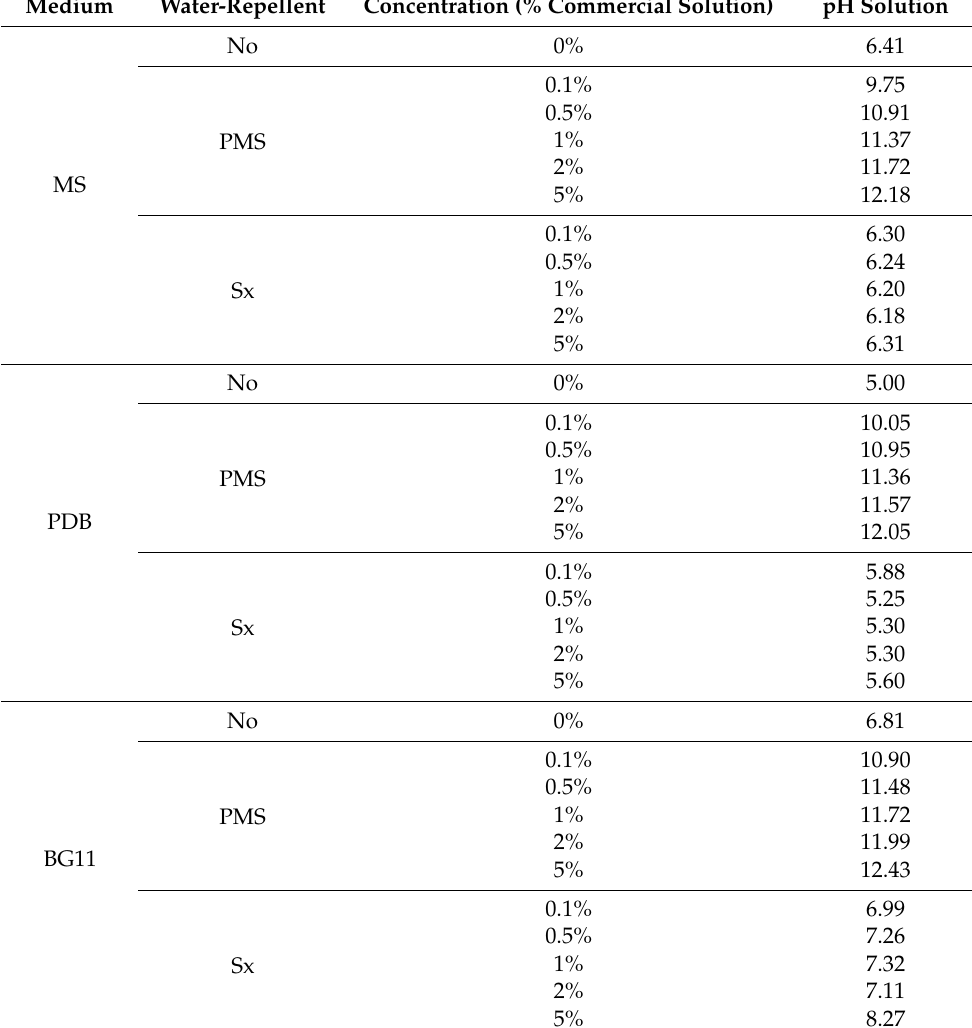
Table 3. pH measures of solutions containing Sx and PMS at 0, 0.1, 0.5, 1, 2 and